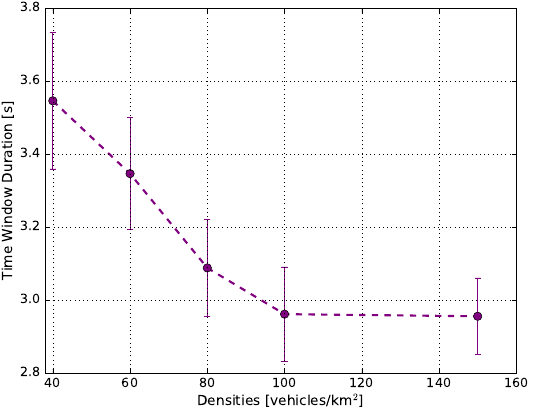
Figure 12. Average time window duration in which there were no changes to the egocentric betweenness